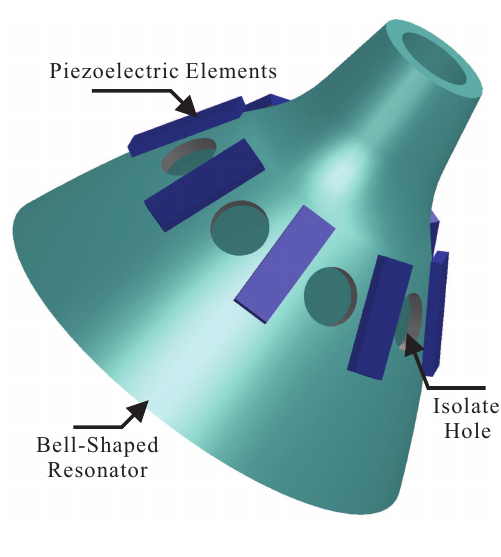
Figure 3. Schematic of the